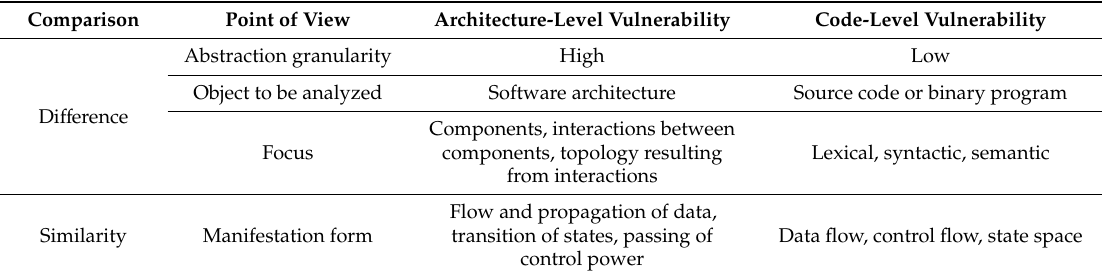
Table 2. Comparison of software architecture vulnerability with code-level